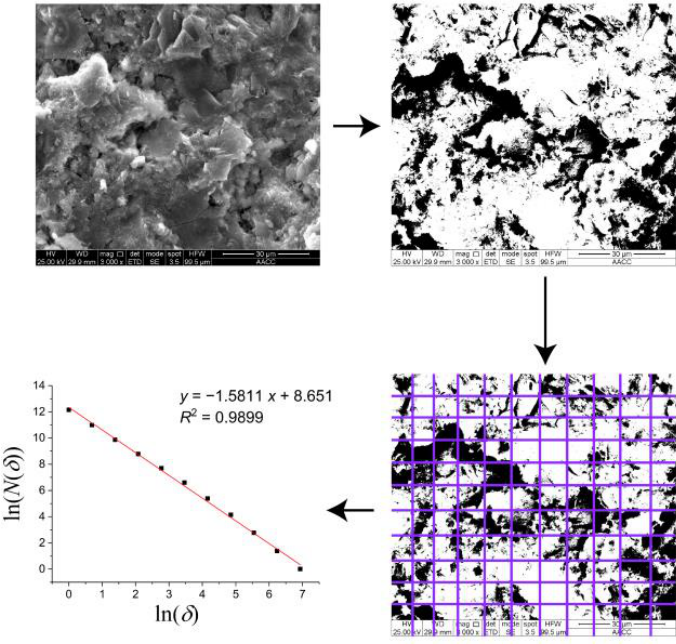
Figure 5. The analysis procedure of the fractal dimension of the SEM image. Figure 6 and Table 2 show that the correlation coefficients were greater than 0.99 for all cases; therefore, the calculated fractal dimensions were effective. The statistical self- similarity and the fractal characteristics of the pore structure of the gypsum rock were confirmed. According to the fractal theory, the increase in the fractal dimension indicates the increase in the degree of damage and the increase in complexity of the pore structure. According to the obtained fractal dimensions, the linear relationship between the fractal dimension and the degree of damage to the rock can be expressed as [27]: